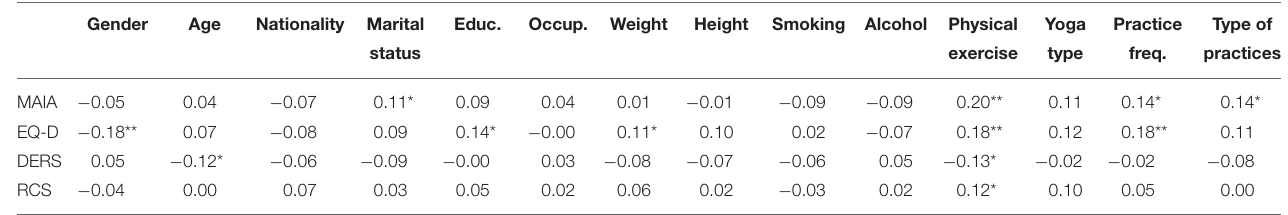
TABLE 2 | Bivariate correlations of the outcome variables with socio-demographic characteristics, life habits and aspects of yoga practice. Gender Age Nationality Marital Educ. Occup.